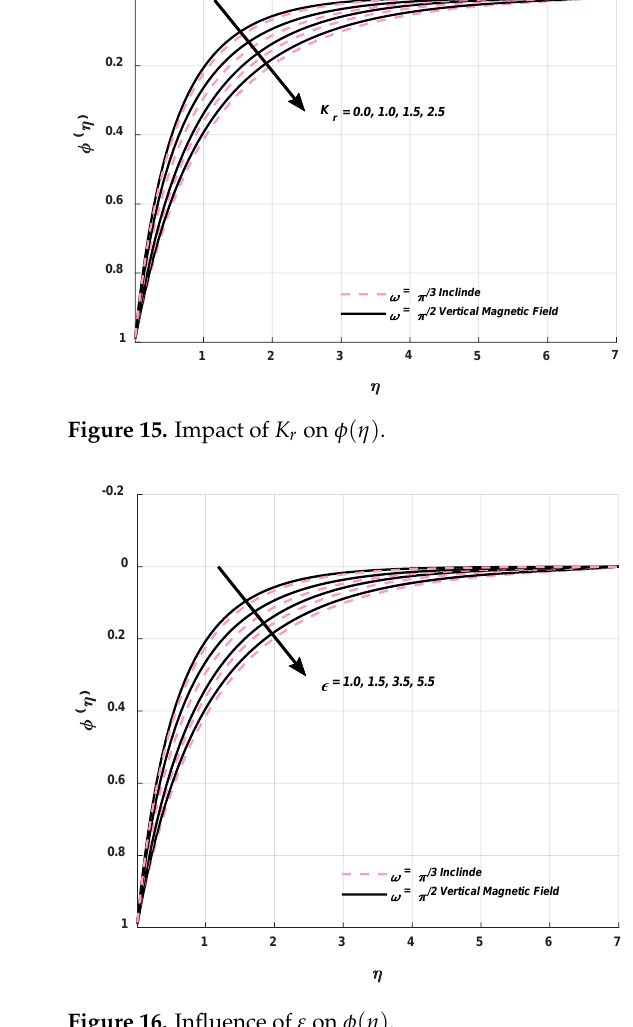
on . on . on . 𝜀𝜀 𝜀𝜀 𝜙𝜙(𝛾𝛾) 𝜀𝜀 𝜙𝜙(𝛾𝛾)